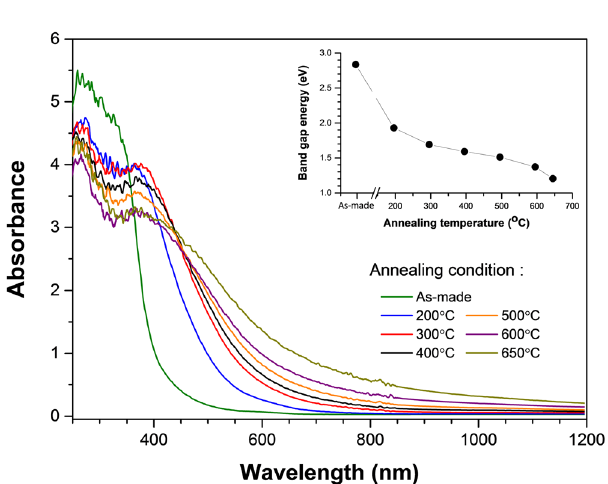
Figure 1. X-ray powder diffraction patterns of Co-doped CeO 2 samples annealed at different temperatures. Curves have been shifted vertically for the sake of clarity.